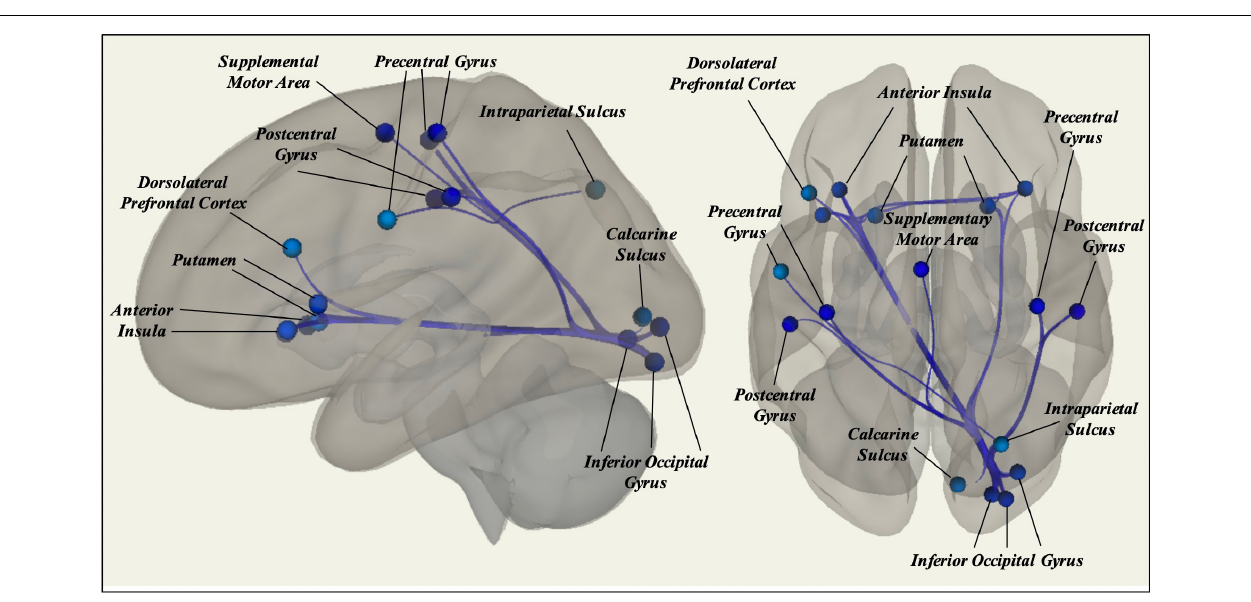
FIGURE 2 | Significant effects of Age on static rsFC controlling for Gender, WM Performance, and Framewise Displacement, with resting-state functional connectivity tending to decrease among ROIs in different canonical functional